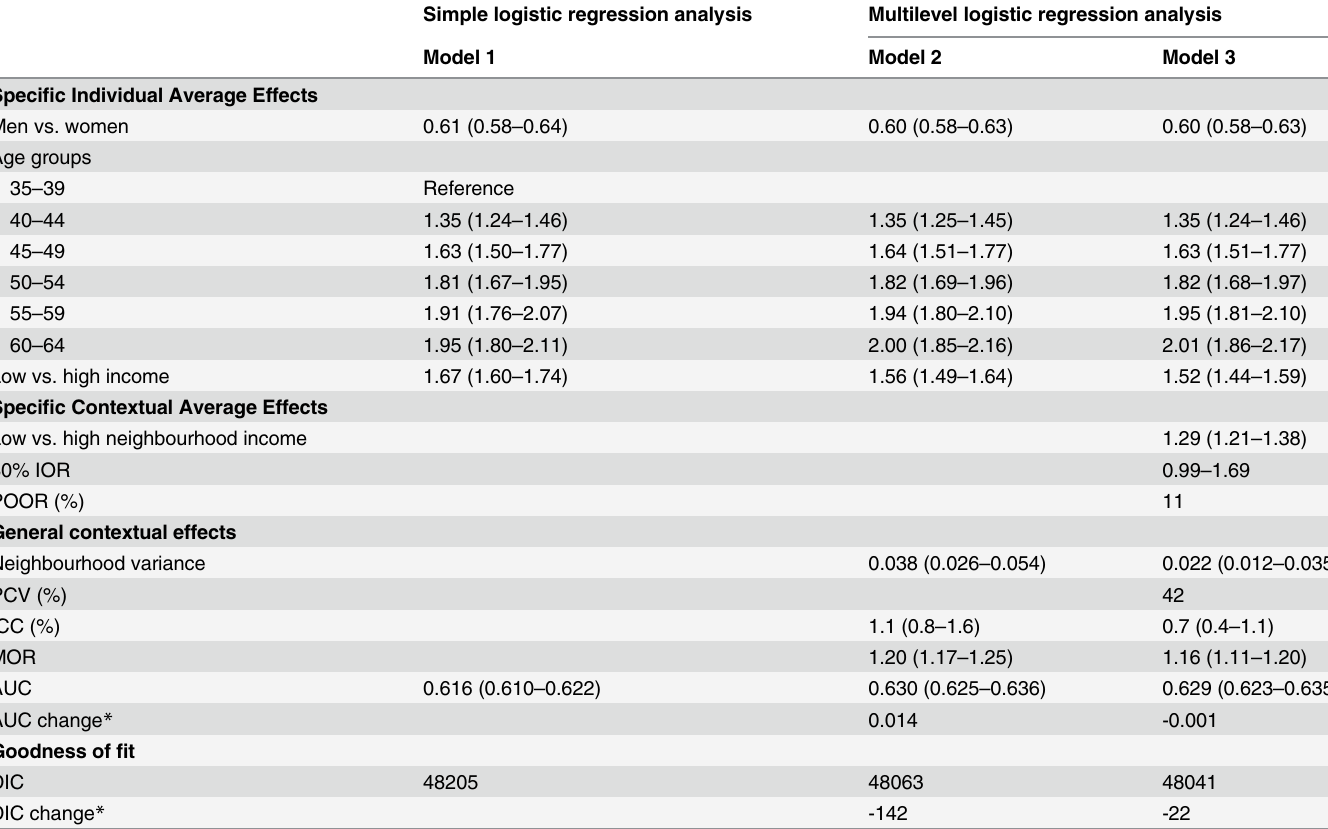
Table 2. Multilevel logistic regression analysis of psychotropic drug use in the 35 – 65 year-old population of Malmö, 2006. Values are odds ratios (OR) with 95% confidence interval (CI) unless stated otherwise. The intercept is not shown in the table. Simple logistic regression